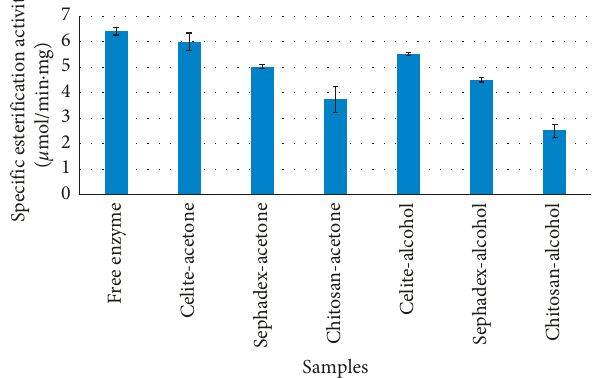
2mg/mL (pH 7.0 (cid:31)